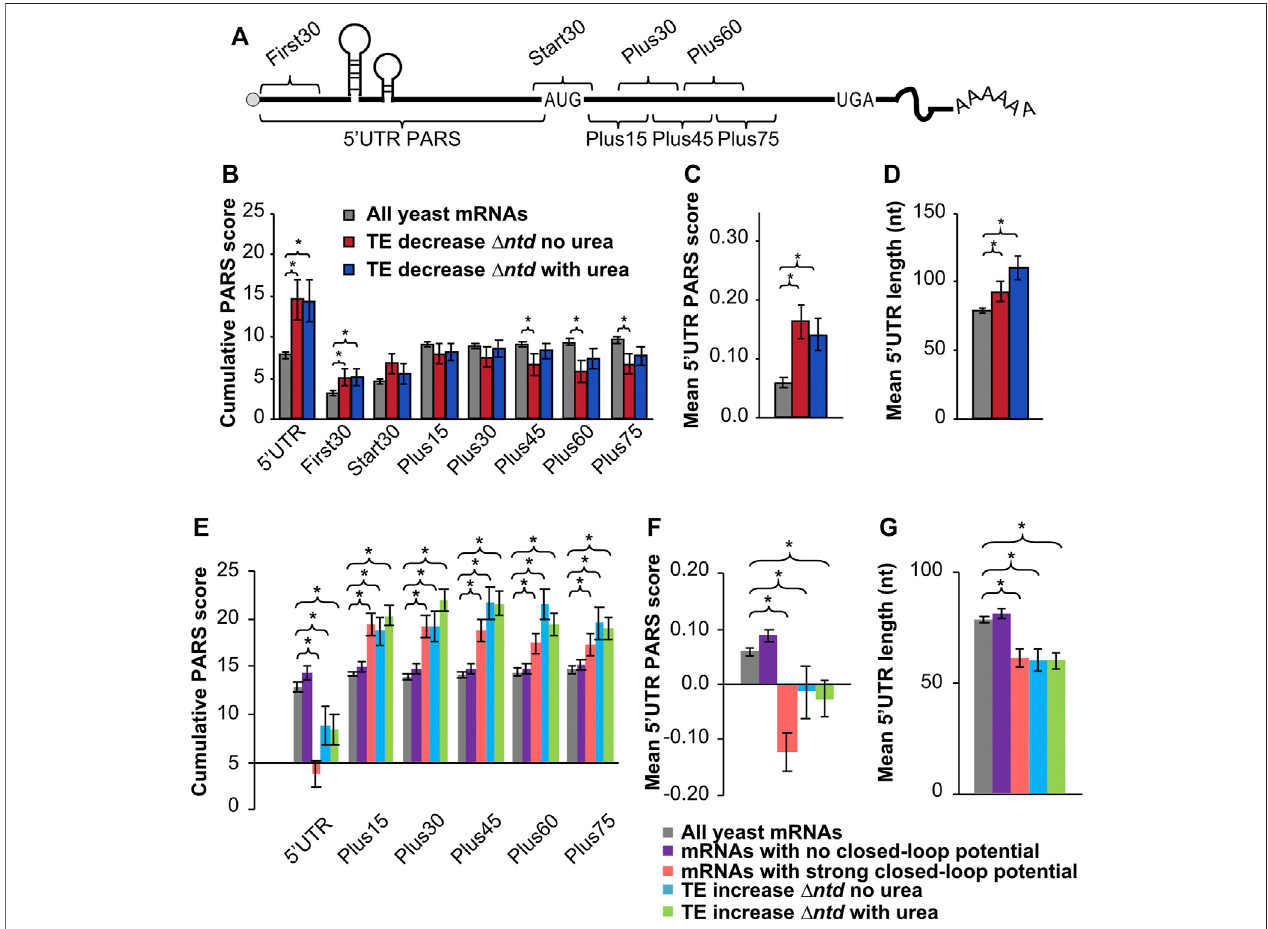
FIGURE4| Comparison ofPARS (ParallelanalysisofRNAstructure) scores indicatesa higher propensity for secondarystructurein the5 ′ UTRs ofmRNAs that are dependent on the NTD for translation, and less associated with closed-loop factors. (A) Schematic showing 5 ′ -UTR and CDS intervals for cumulative PARS scores. Thesumofscoresfor all5 ′ -UTRnucleotides(5 ′ UTRPARS); for the fi rst30nucleotides (First30PARS);for30nucleotidessurroundingthestartcodon (Start 30PARS);andfornucleotideswithintheORF,from+1to+30(Plus15),+16to+45(Plus30),+31to+60(Plus45),+46to+75(Plus60),and+61to+90(Plus75). (B , C) The mean PARS scores (calculated from data reported in reference (Kertesz et al., 2010)) for indicated cumulative regions (B) , or for individual nucleotides in the 5 ′ UTR (C) are indicated for all yeast mRNAs with available PARS scores (gray, n (cid:1) 2679); mRNAs with decreased TE ( ≥ 1.5-fold) in Δ ntd relative to WT in media lacking urea(red, n (cid:1) 138);and for mRNAs withdecreased TEin Δ ntd relative toWTin3%urea(navy, n (cid:1) 156). (D) Averagelength of5 ′ -UTRfor theindicated sets of mRNAs. (E – G) PARS and 5 ′ UTR length analysis calculated for the indicated gene sets, with p values from Student ’ s t test indicated (* p < 0.05): grey bar, all yeast mRNAs with available PARS scores ( n (cid:1) 2679); purple bar, mRNAs with no closed-loop potential, characterized for de-enrichment in immunoprecipitation of eIF4F and Pab1, and enrichment in immunoprecipitation of eIF4E-binding proteins as shown in (Costello et al., 2015); red bar, mRNAs with strong closed-loop potential, characterized for de-enrichment in immunoprecipitation of eIF4E-binding proteins and enrichment in immunoprecipitation of eIF4F and Pab1, as shown in (Costello et al., 2015); blue bar, mRNAs with increased TE in NTD deletion mutant as compared to WT without urea; green bar, mRNAs with increased TE in NTD deletion mutant as compared to WT in 3% urea. (E) Average PARS scores calculated for the indicated sets of mRNAs for each 5 ′ -UTR or CDS interval described in Figure 4A . (F) Average PARS score calculated for entire 5 ′ -UTR for the indicated sets of mRNAs. (G) Average length of 5 ′ -UTR for the indicated sets of mRNAs.